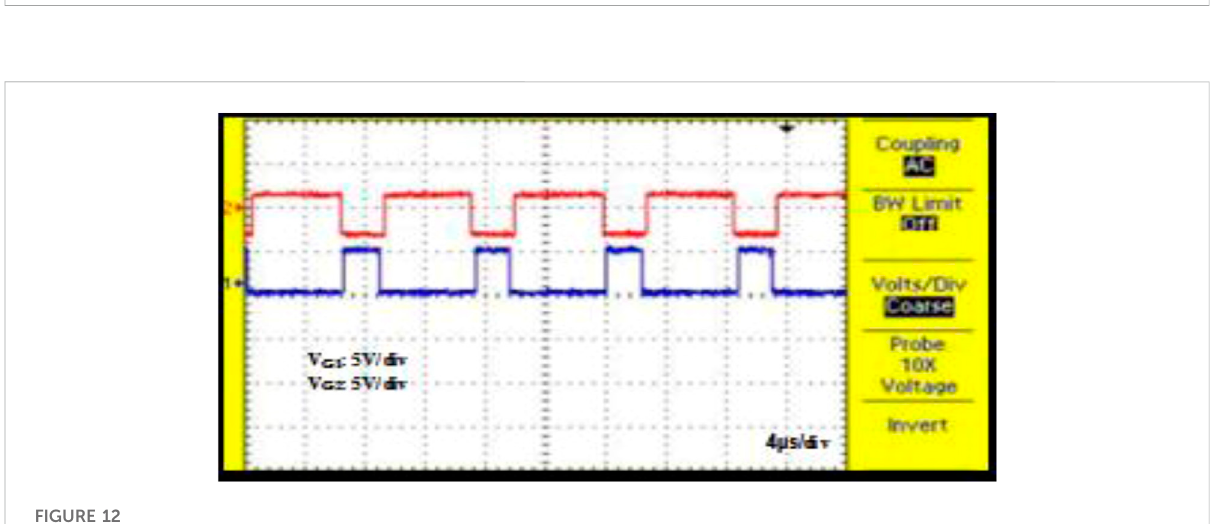
FIGURE 12 Switching pulses for the isolated DC-DC